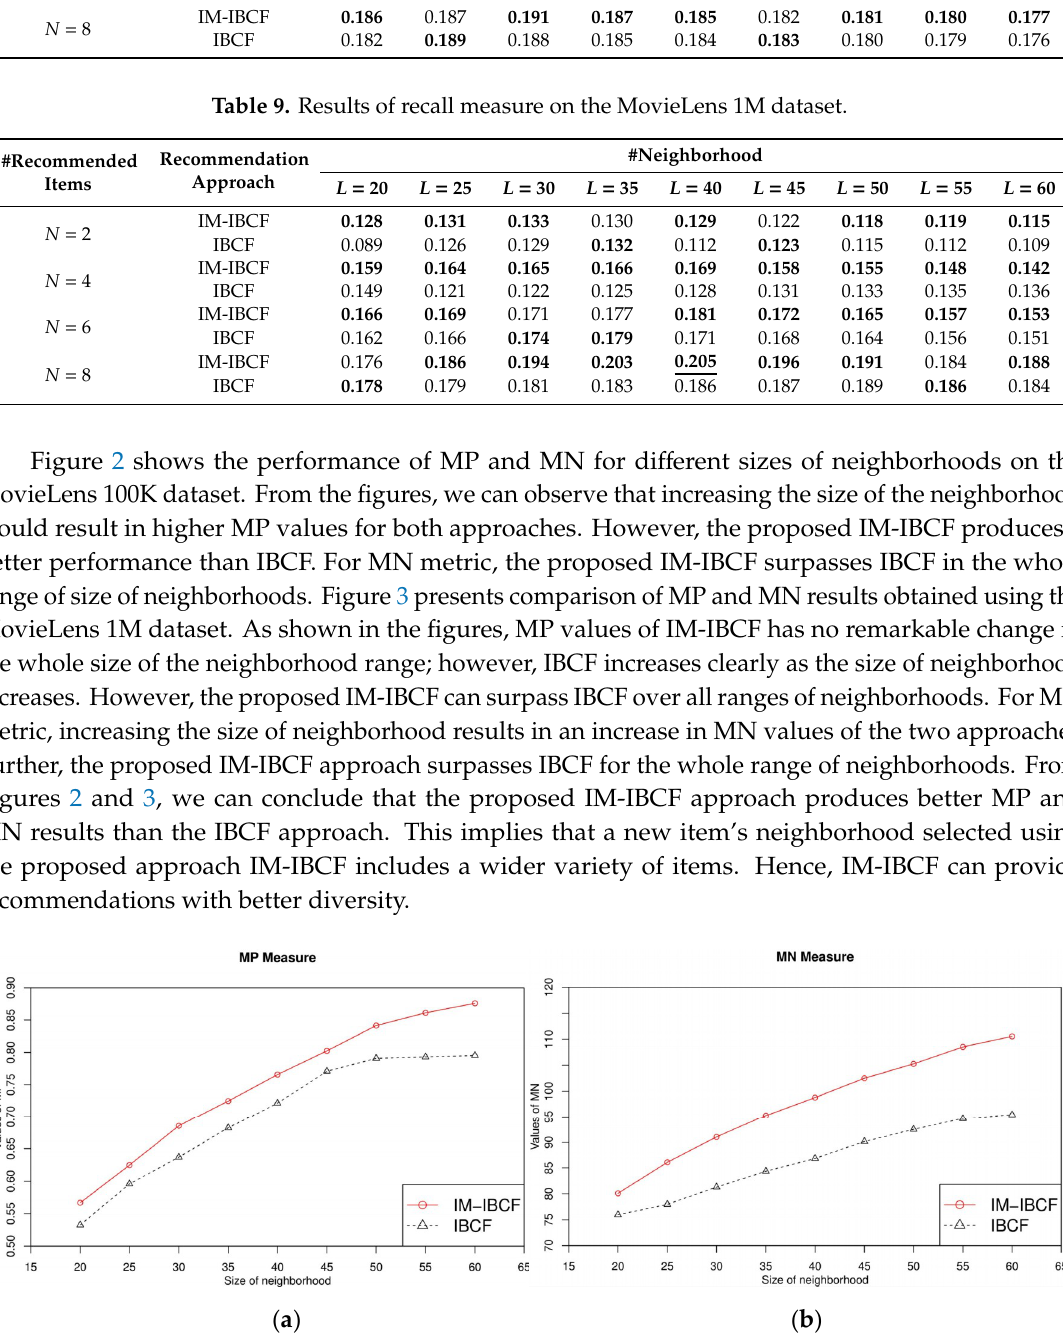
( b ) Figure 3. MP ( a ) and MN ( b ) results with MovieLens 1M dataset. Experimental results above show that the proposed approach has better accuracy and diversity than IBCF on the CNICS problem. Because a new item often has no rating records, the IBCF uses JAC measure to compute similarity by comparing attribute values between items, however it cannot explore the hidden information from the given attributes. By extending binary relations between different attributes, the proposed approach constructs interrelated attributes for each item so that more information can be utilized in evaluating the similarity computation. Further, items in a new item's neighborhood will be more similar to this new item, which shows that the accuracy of the recommendation has improved. Moreover, items with more common attributes will have higher similarity in IBCF, thereby making items in a neighborhood to concentrate on a few types. The proposed approach can be used to extract characteristic from different attributes, which can enhance